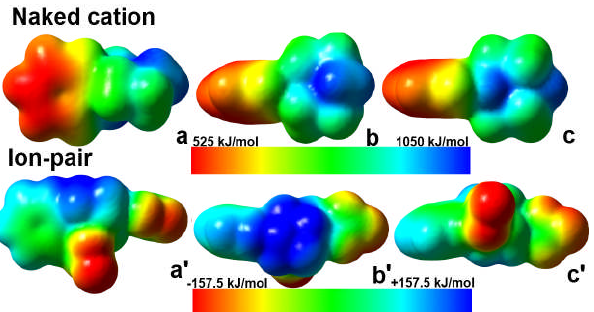
H N ) 2+ showing the charges 10 16 2